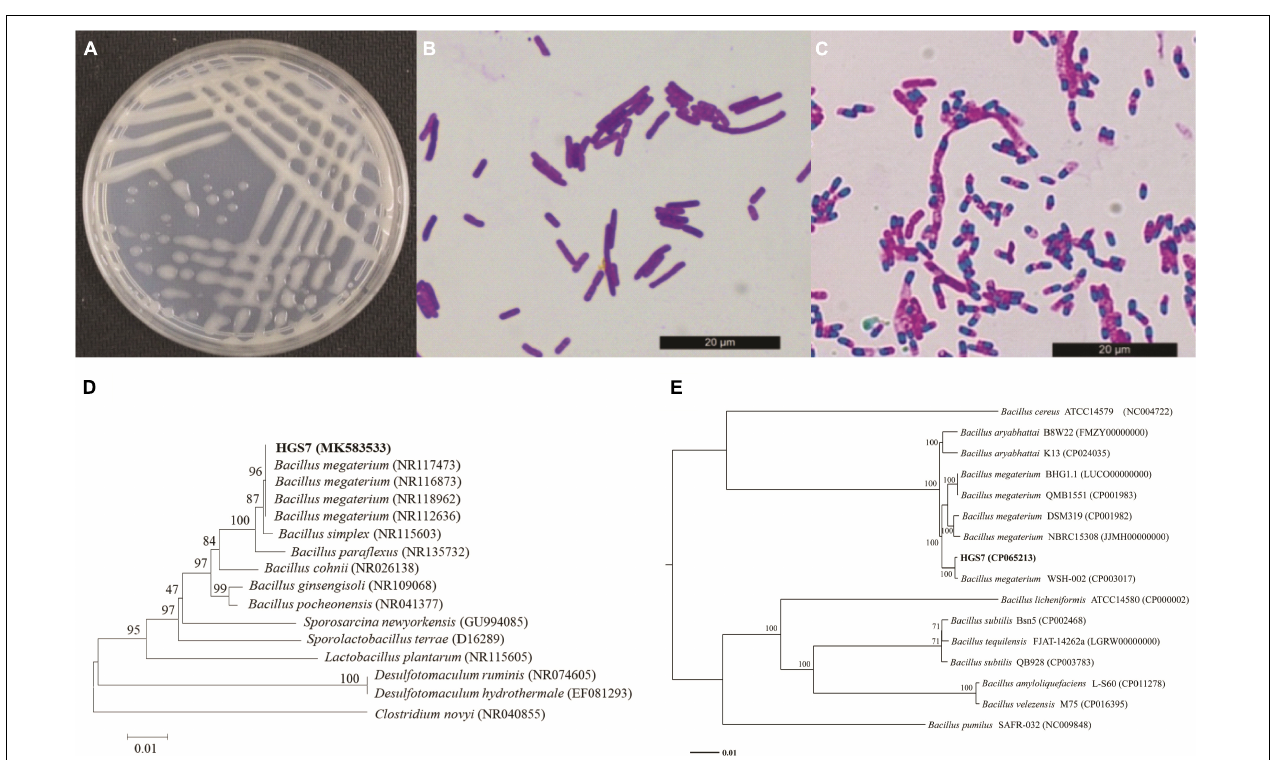
FIGURE 2 | Characterization of B. megaterium HGS7. (A) Colony features on LB after 24 h. (B) Gram-positive staining. (C) Endospore staining. (D) Phylogenetic tree based on 16S rRNA genes. (E) Phylogenetic tree based on single-copy nuclear genes. The trees were constructed by MEGA version 6.0 using neighbor-joining analyses of 1,000 bootstrap